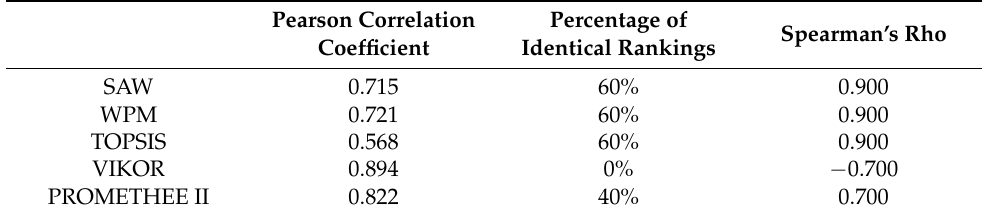
Table 11. The statistical analysis of the